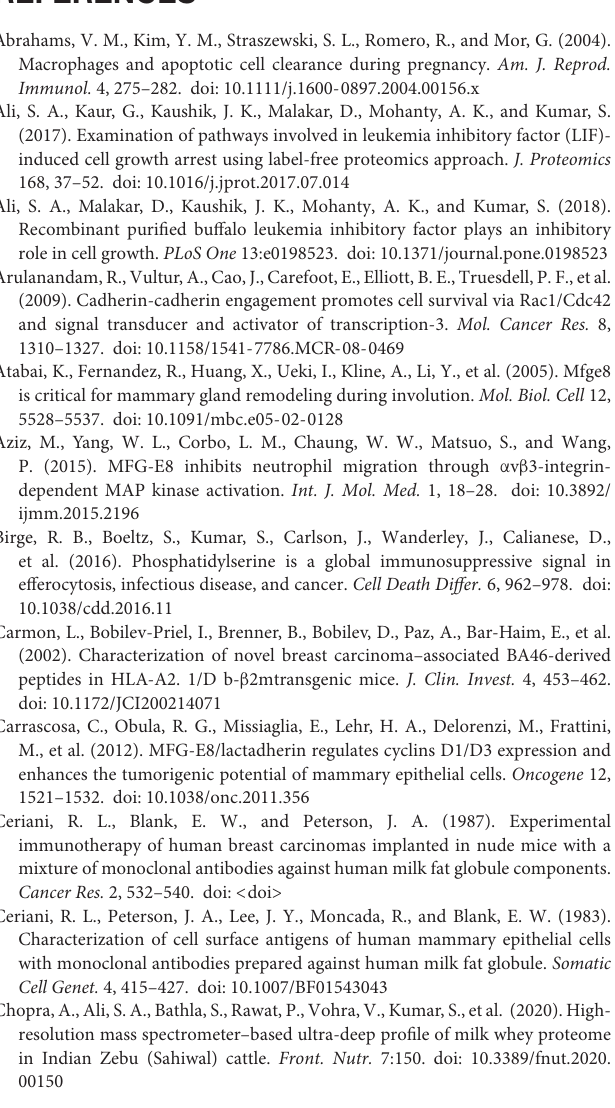
Supplementary Table 6 | Information from string enrichment analysis for all the associated proteins involved in network